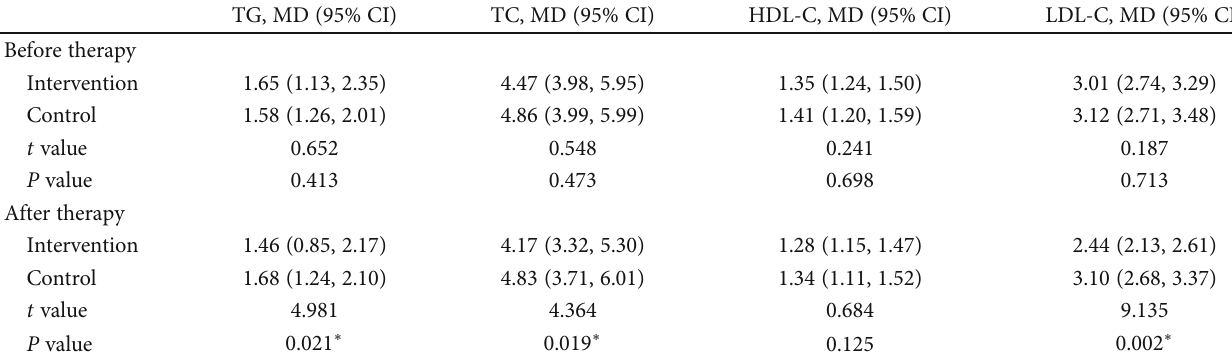
Table 9: The comparison of lipid pro fi les between intervention and control groups.